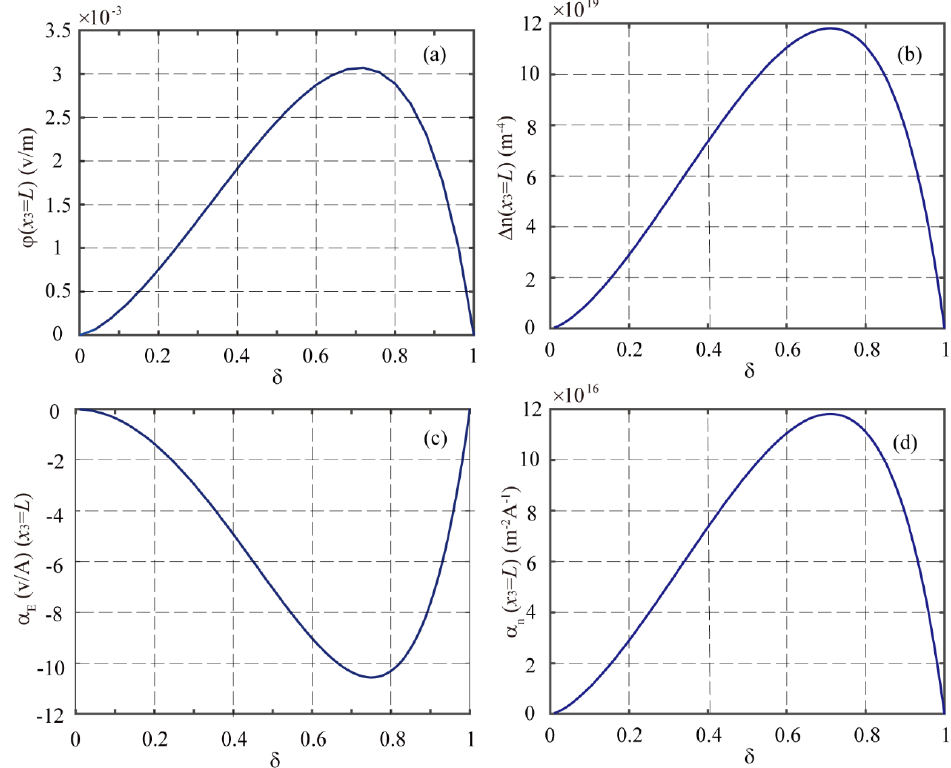
α α ϕ Δ , ( b ) n , ( c ) , and ( d ) at x 3 = L of the LMPS beam with n 0 = E n δ .